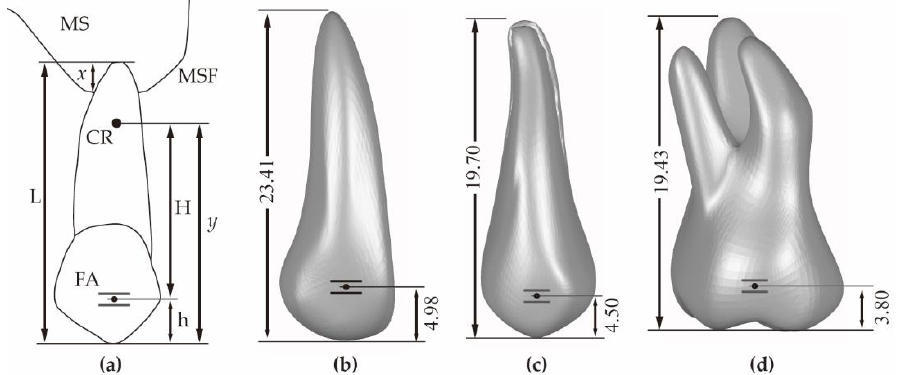
Figure 2. Schematic of critical dimension variables ( a ) and the models of the canine ( b ), the premolar ( c ), and the molar ( d ). CR: the center of resistance of the tooth; FA: the facial-axis point on the crown; L: the length of the teeth; h: the bracket height, the distance between FA and the tooth cusp or edge; H: the distance between CR and FA; x : penetration depth of the root; y : the indicator of CR position, the distance from CR to the tooth cusp or edge.